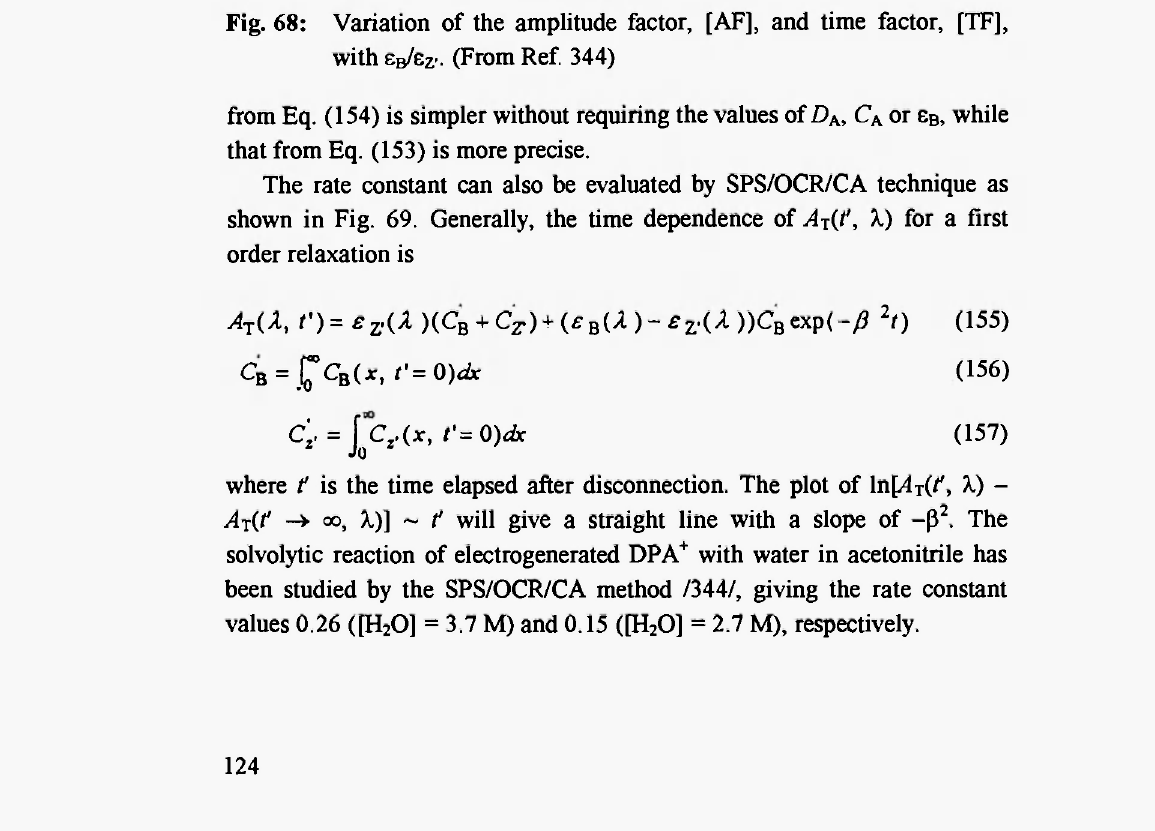
Fig. 68: Variation of the amplitude factor, [AF], and time factor, [TF], with Εβ/εζ·. (From Ref.